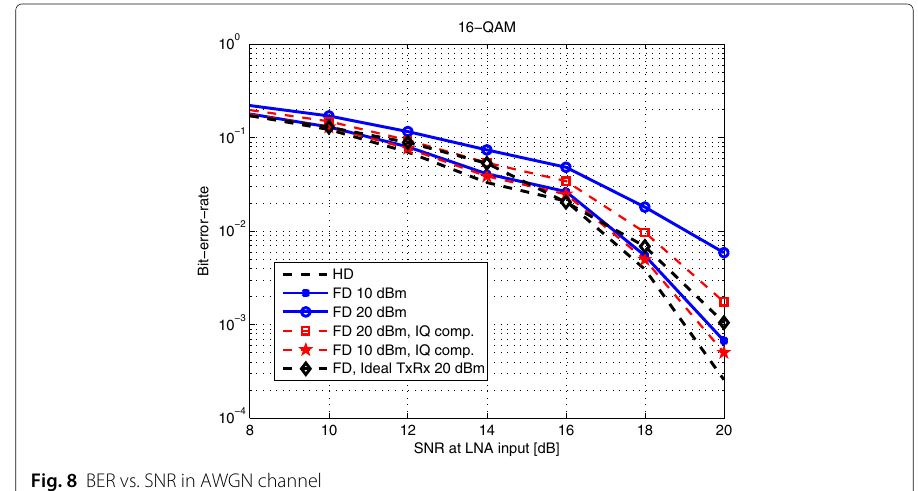
Fig. 8 BER vs. SNR in AWGN channel